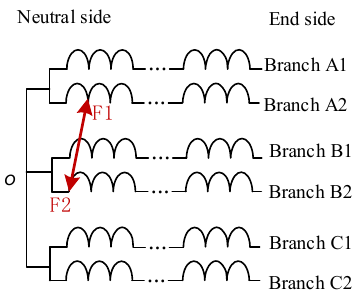
Figure 15. Diagram of the short ‐ circuit fault in rotor windings.